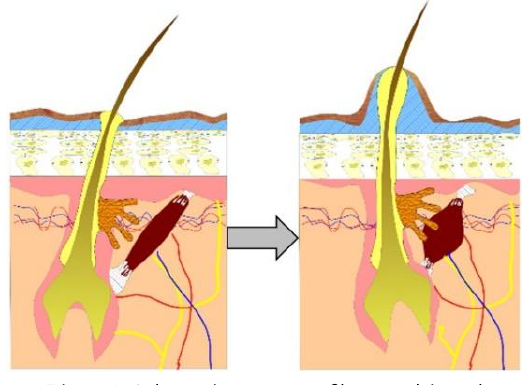
Figure 1. Schematic structure of human skin and generation of goose